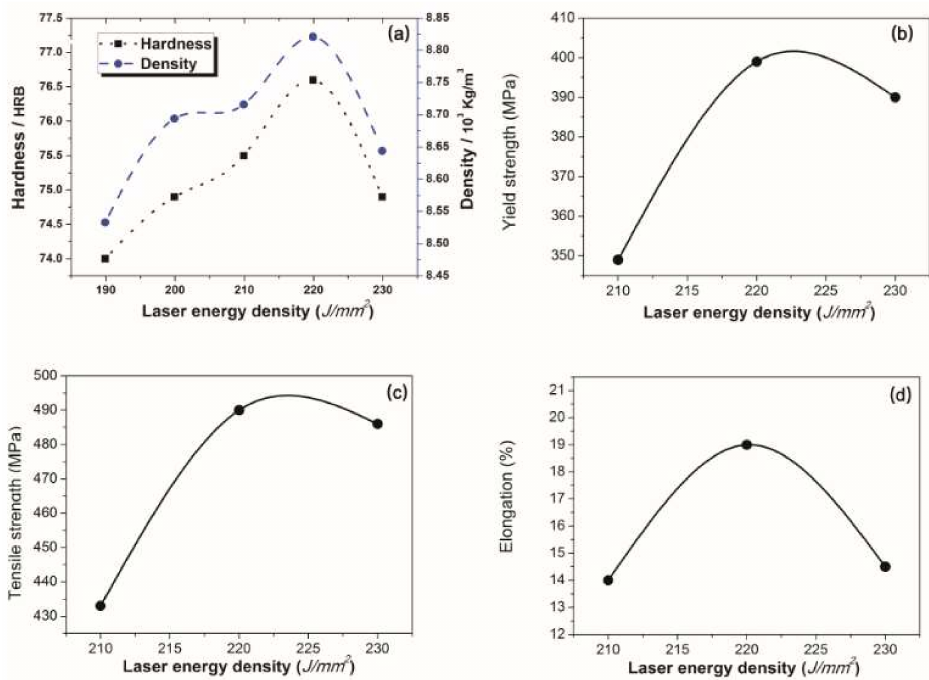
Figure 2. Mechanical properties at different laser energy densities. ( a ) The hardness and density of the samples; ( b ) The yield strength of the samples; ( c ) The tensile strength of the samples; ( d ) The elongation of the samples.